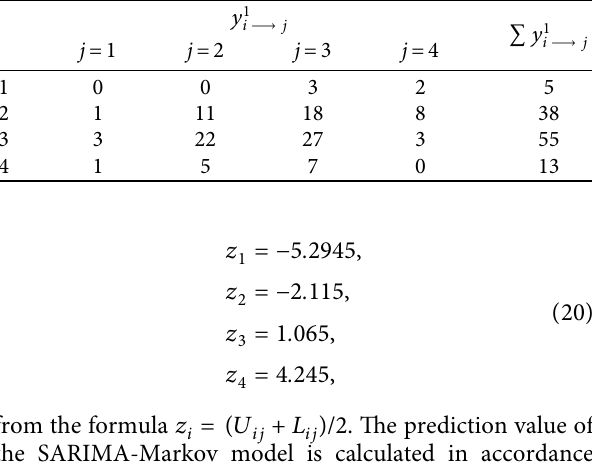
Table 4: Statistics of the one-step state transfer